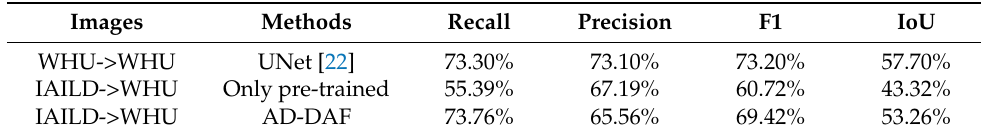
Table 3. The results on the WHU satellite building dataset I.